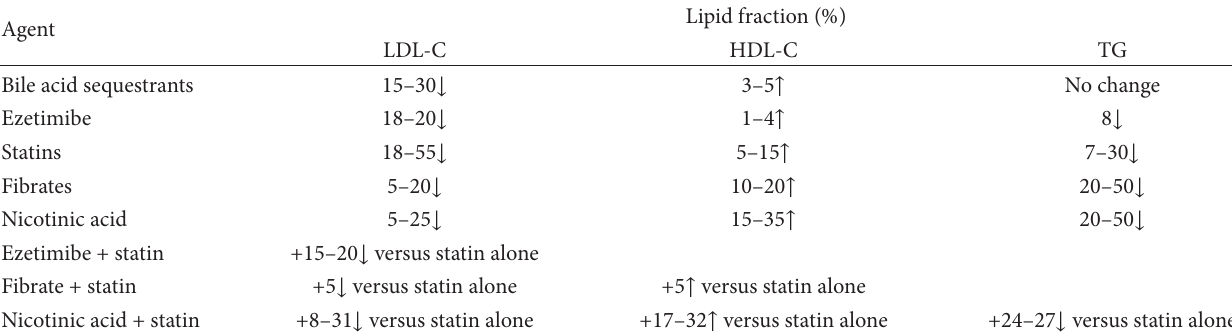
T 1: Established pharmacological agents for dyslipidaemia management and their effects on lipid